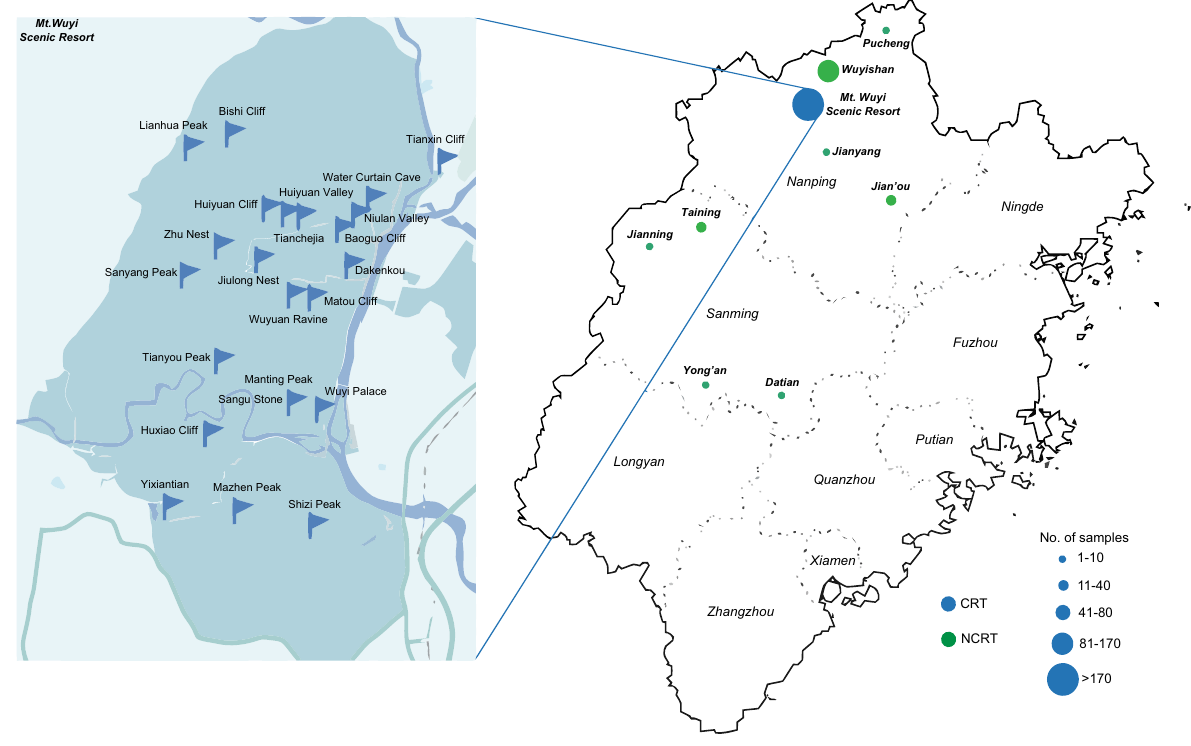
Fig. 1 Geographical distributions of sampling points in the current study. The enlarged part indicates representative sampling points located in Mount Wuyi Scenic